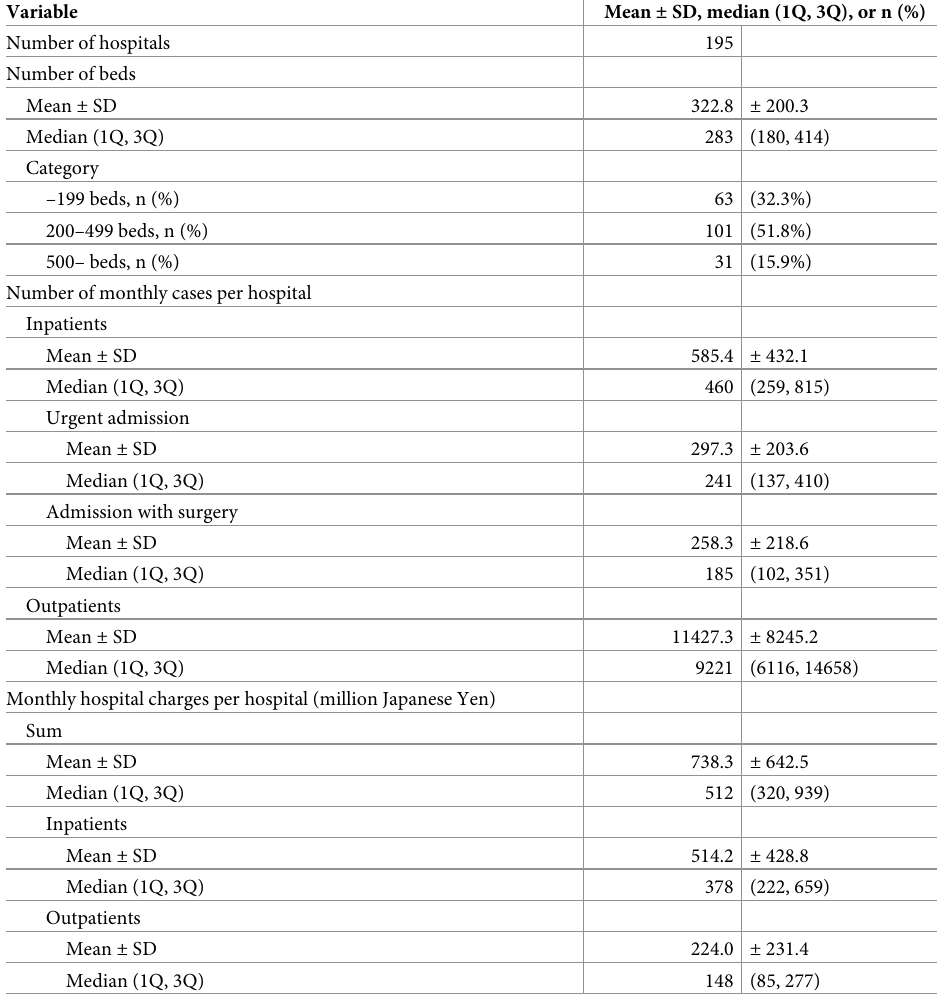
Table 1. Characteristics of hospitals for the